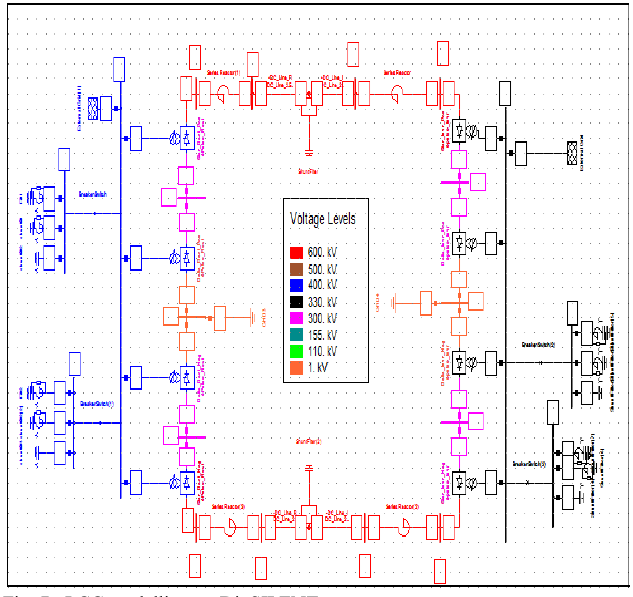
Fig. 7. LCC modelling on DigSILENT